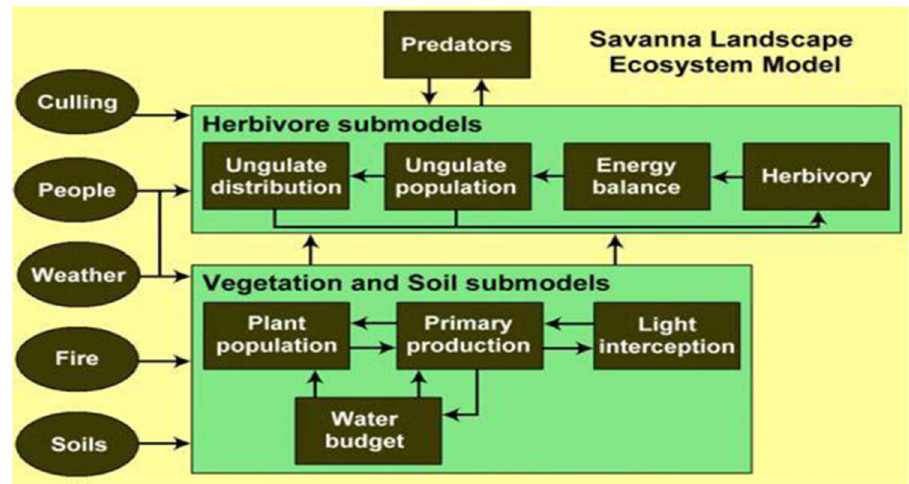
Figure 2. Schematic representation of the SAVANNA model Figure 2 Schematic representation of the SAVANNA model [17]